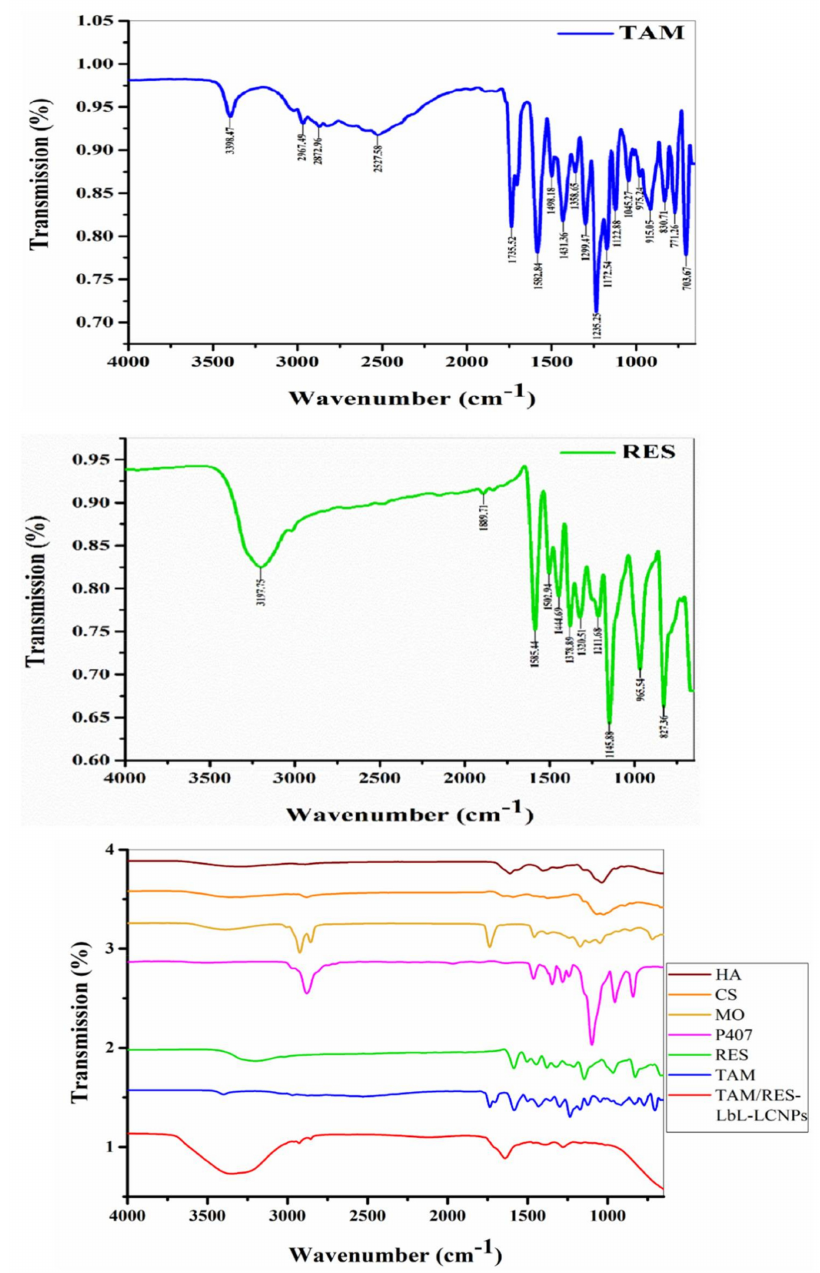
Figure 5. Fourier transform infrared spectroscopy analysis of TAM, RES, and other components involved in TAM/RES–LbL-LCNPs preparation. HA: hyaluronic acid; CS: chitosan; MO: glyceryl monooleate RES: resveratrol; TAM: tamoxifen